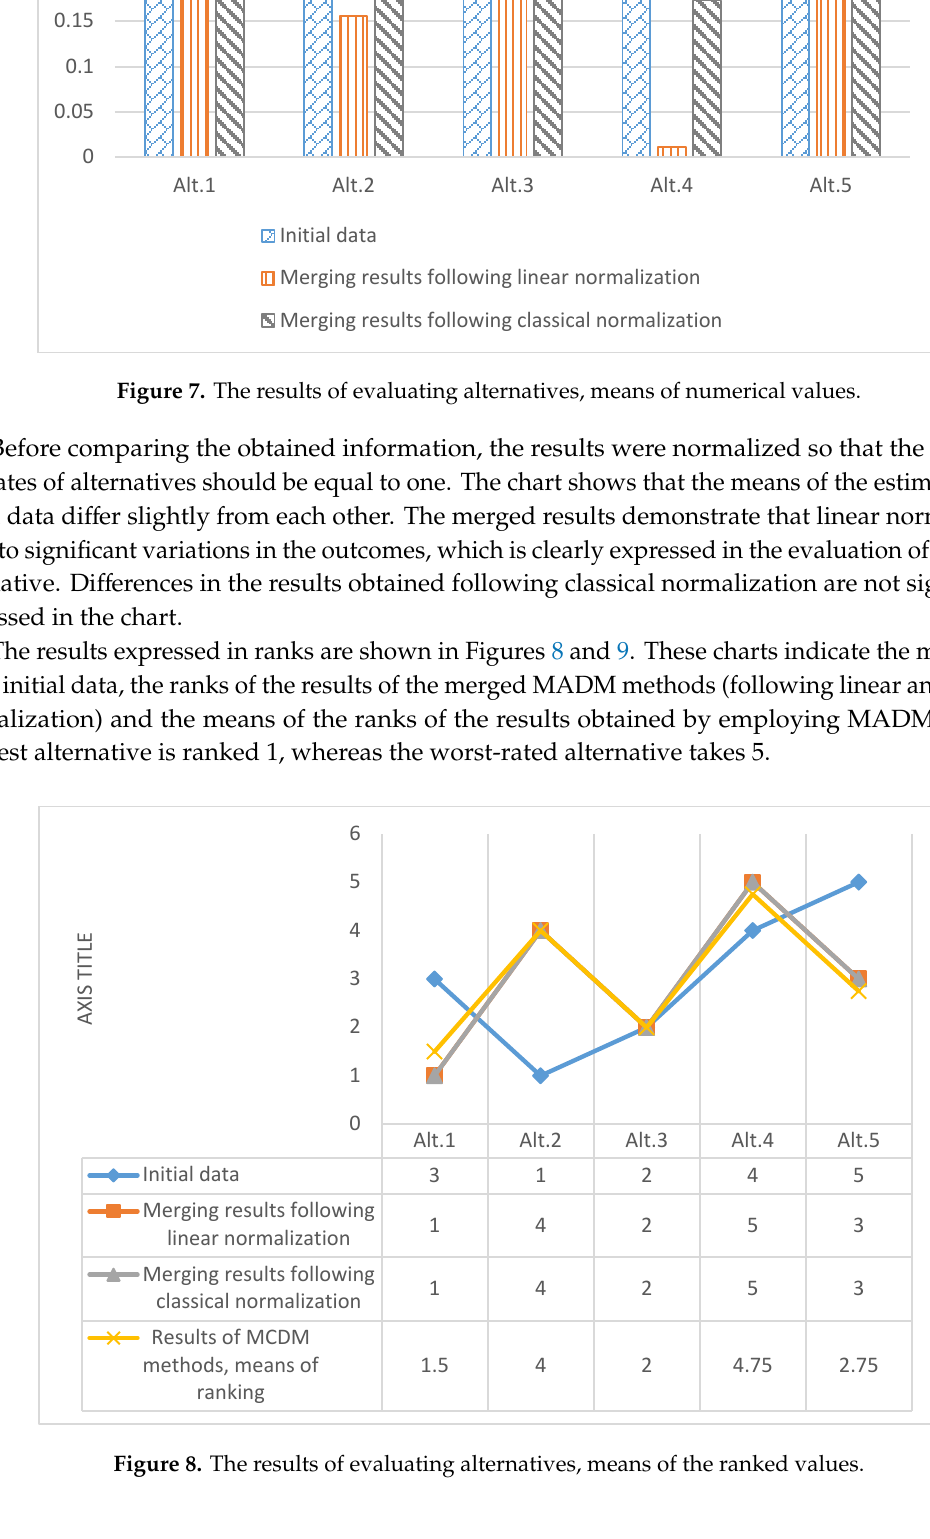
Figure 9. A comparison of the results of evaluating alternatives. Table 3 shows that the sum of the estimates for each alternative is equal to 1, which facilitates comparing them. A comparison of the ranked results provided in Figures 5 and 6 demonstrates that the employed methods of the linear and classical normalization of MADM results have determined all alternatives equally. For comparing the mean values of the initial estimates with the findings